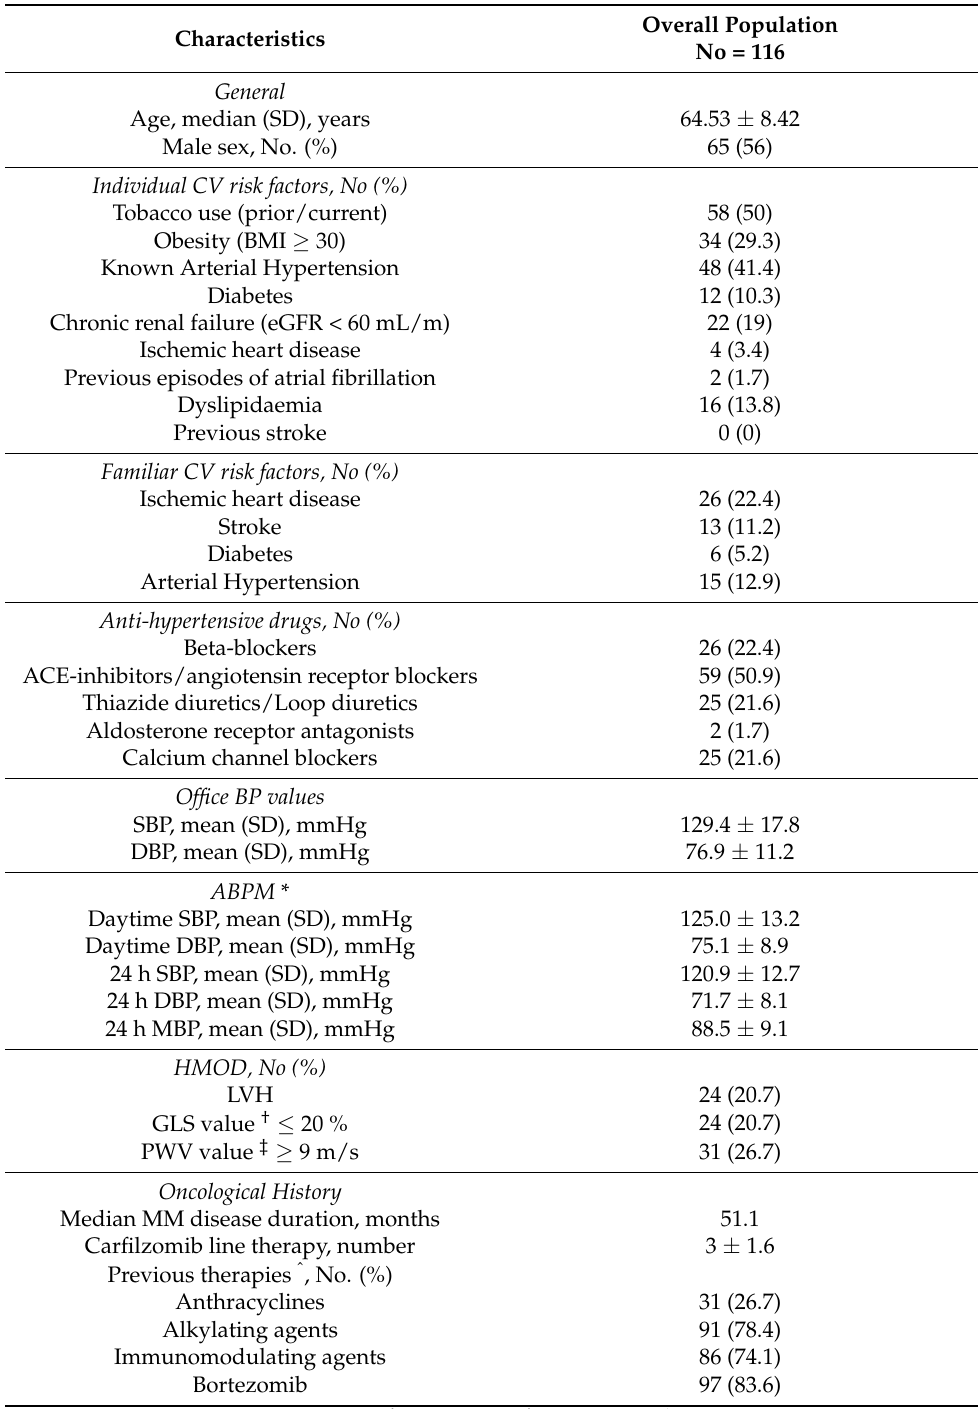
of cardiovascular toxicity (Table S1 details the CFZ regimens of patients enrolled, Table S2 details the cumulative dosages of CFZ at first CVAE, available in Supplementary Materials). Table 1. Baseline population